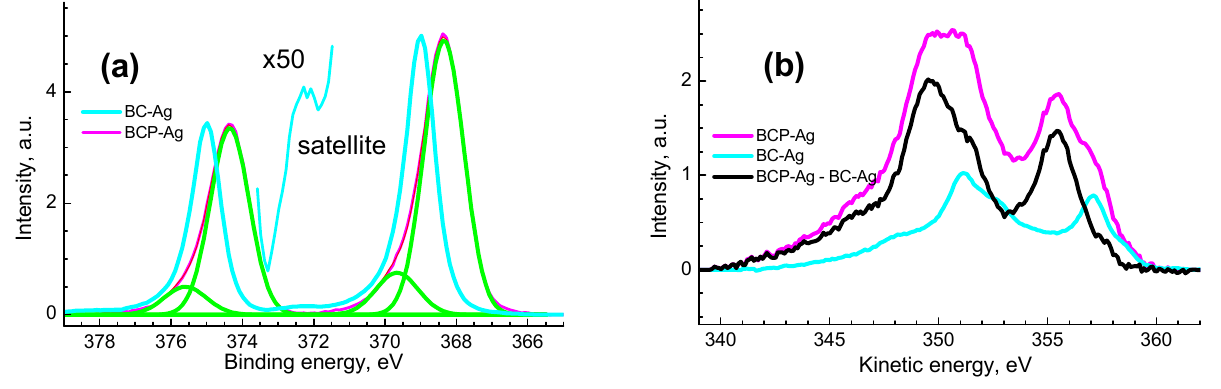
Figure 6 shows the Ag 3d photoelectron spectra and MNN Auger spectra of the composites, and Table 3 shows their characteristics. The binding energies and the widths of the photoelectron peaks differ markedly, which indicate different chemical states of Ag atoms and the presence of at least two chemical states of atoms in BCP-Ag nanocomposite.